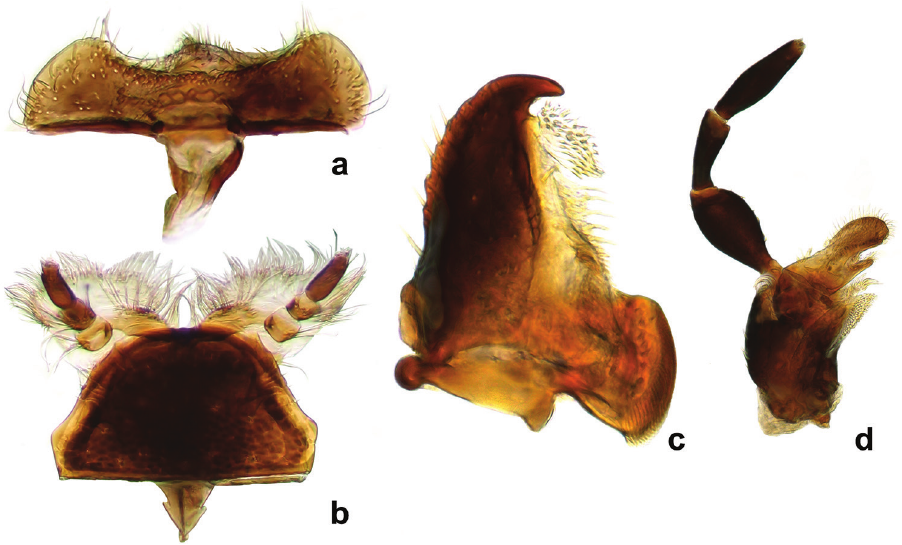
Figure 2. Evanesternum pulsatum (d’Orchymont) mouthparts a labrum b labium c mandible d maxilla.